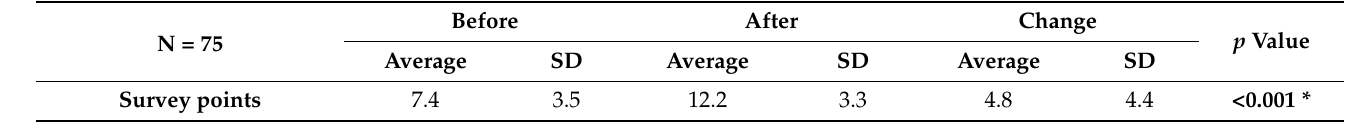
Table 7. Dietary assessment based on scores from the author’s questionnaire before education and treatment and after